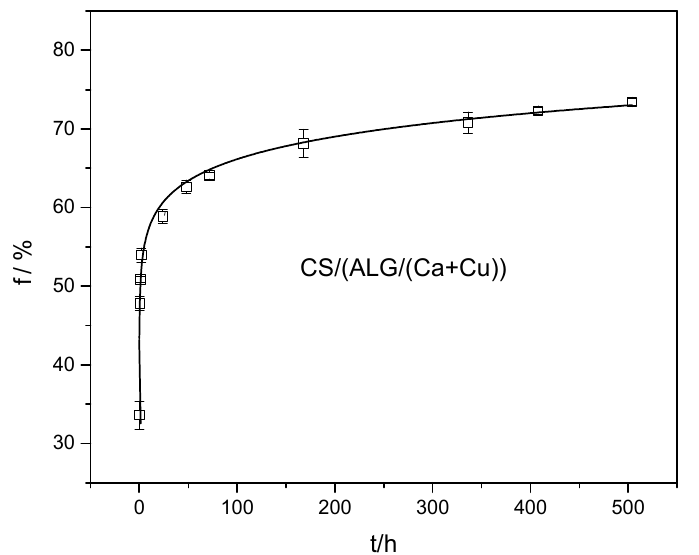
Figure 7. Percentage of released Cu(II) complex, ( f ) with time from CS/(ALG/(Ca+Cu)) microcap- sules.